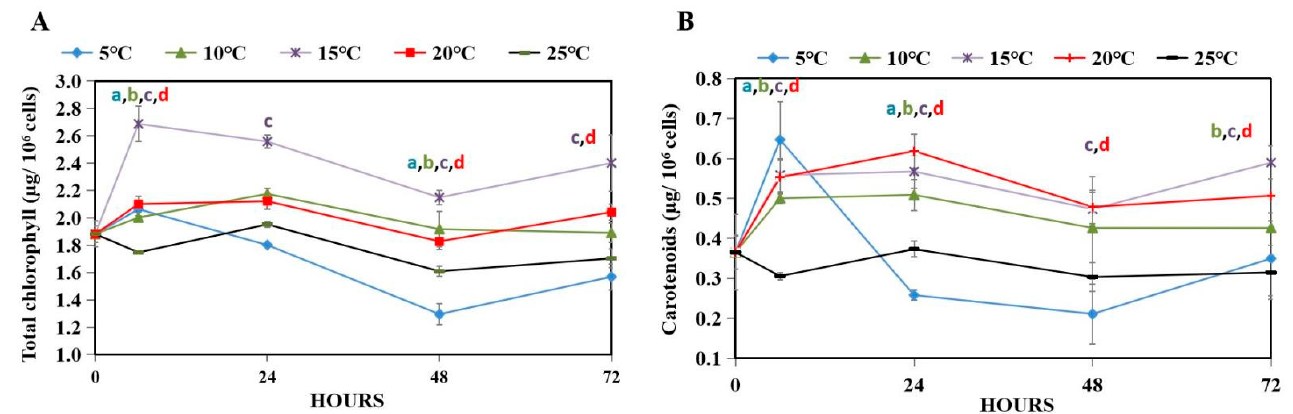
Figure 3. Chlorophyll ( A ) and carotenoid ( B ) content of C. reinhardtii cultivated under different temperatures. All data are means ± SD of three biological replicates. Different lowercase letters indicate significant differences between 25 °C and each temperature ( p < 0.05).